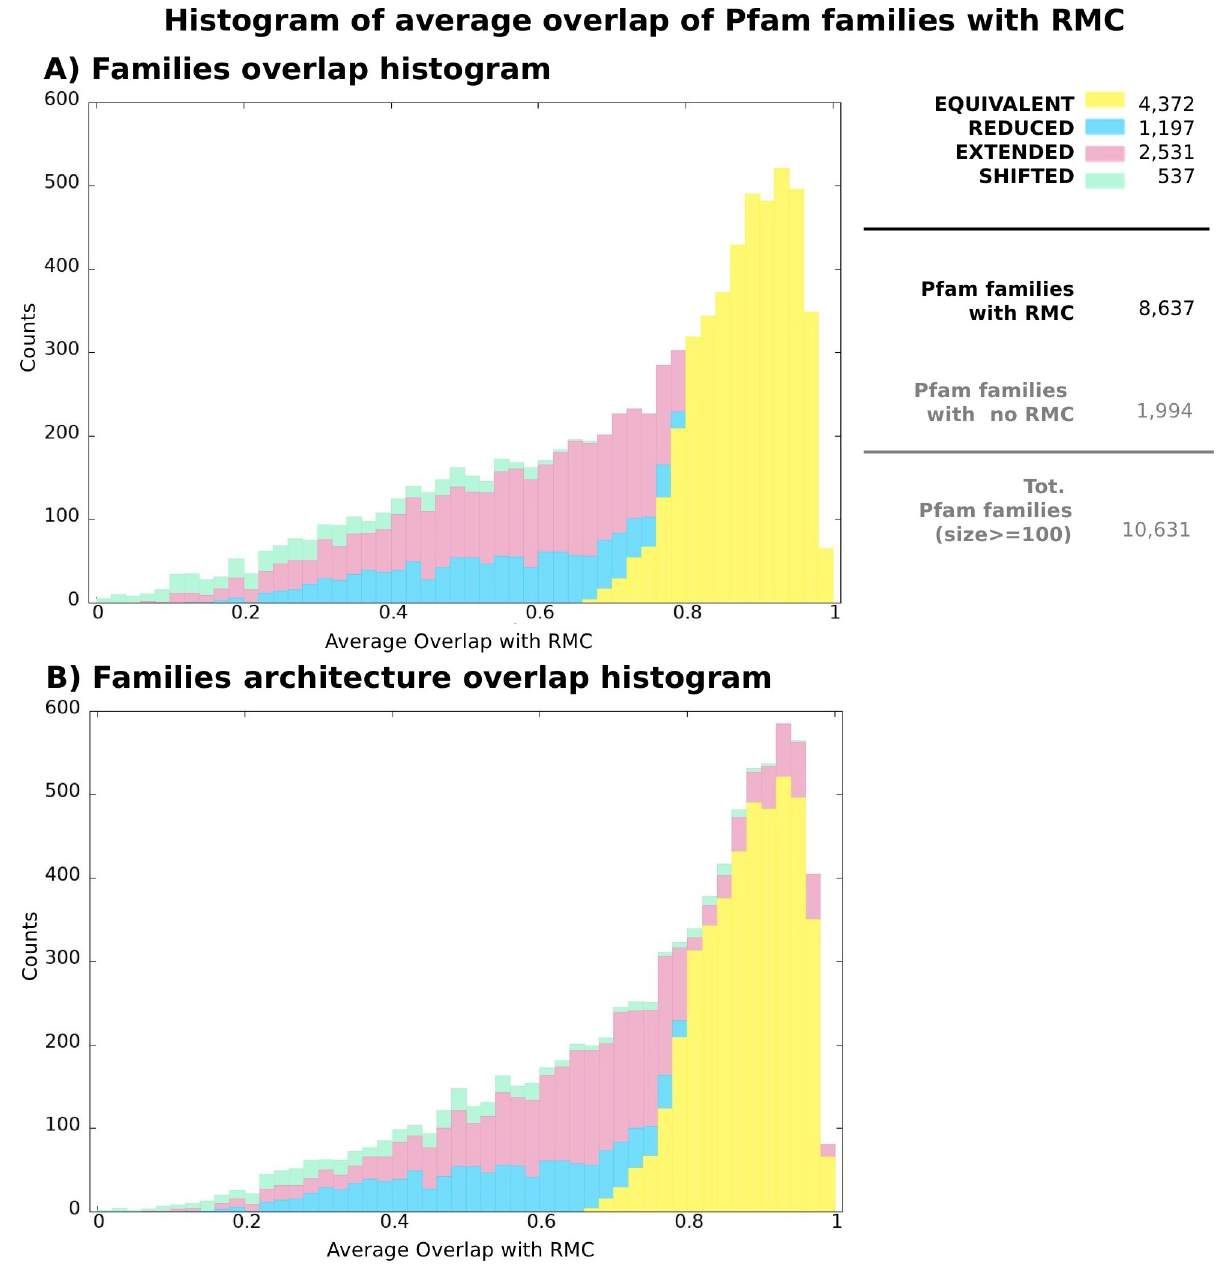
Fig 6. Histograms showing average overlap between Pfam families and their representative MCs. Colors reflect the contribution of each MC category to each bin (equivalent, reduced, extended and shifted, see S1(B) Fig and Methods for definitions). A : Overlap between individual Pfam families and their representative MCs B : Overlap between individual Pfam families or architectures and representative MCs. Given a Pfam family and its representative MC (same pairs as in A), we search for a better overlap of the representative MC with any multi-family architecture featuring the original Pfam family and up to two additional families. The reported average overlap value is thus the best between the overlap with the original family and any other such Pfam architecture. Note that the Pfam architecture labels (equivalent/reduced/extended/shifted) are still assigned according to the representative MC overlap to the original Pfam family so as to show to which extent the overlap in each MC category increases with respect to A).